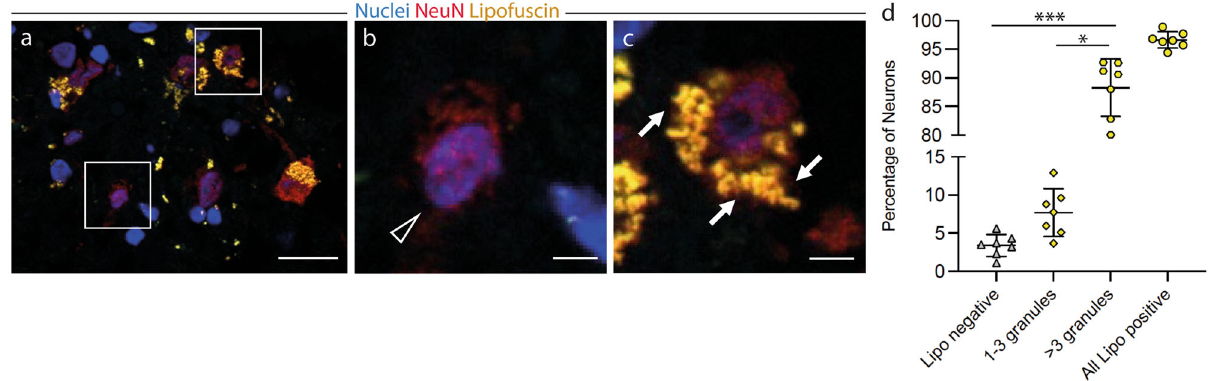
Fig. 1 Lipofuscin-negative neurons in the adult human amygdala indicate a neuronal cell age younger than the individual. a – d Lipofuscin positive and negative neurons in the human amygdala. Immuno fl uorescence staining of tissue sections of the adult human amygdala. Neurons were identi fi ed by NeuN-staining (red) and nuclei were labeled with 4 ’ ,6-diamidino-2-phenylindole (DAPI, blue). Presence of lipofuscin granules (yellow) was assessed by auto fl uorescence signal after excitation at 488 nm. a Boxed areas from the respective overview image, b showing lipofuscin-negative neurons (arrow heads), c and lipofuscin-positive neurons (arrows). d Quanti fi cation of lipofuscin granules per neuron ( n = 7 patients, quanti fi cation of an average of 234 neurons/patient). Proportions of trichotomized lipofuscin levels for subjects L1-L7 (Supplemental Table 1) are presented as mean ± SEM; Kruskal – Wallis One Way Analysis of Variance on Ranks with post-hoc Tukey: * p < 0.05; *** p < 0.001. a Scale bar = 10 µ m, b , c scale bar = 2 µ